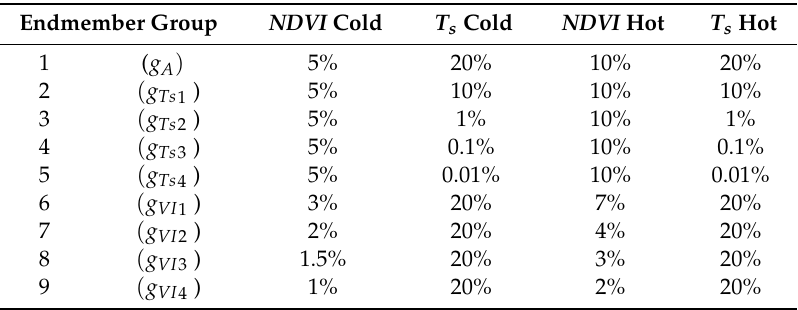
Table 3. Quantiles used for the automated selection of cold and hot